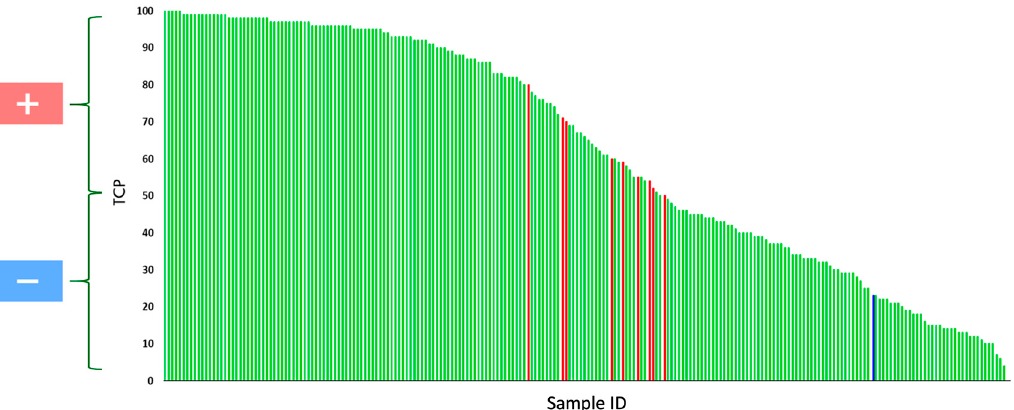
Figure 2. Results of 224 specimens analyzed by PESI-MS, excluding the first incorrect diagnosis. Results concordant with the pathologist’s diagnosis are reported in green ( n = 213), false positive results in red ( n = 9), and false negative results are reported in blue ( n = 2). For these results, the diagnostic concordance rate was 95.1%.